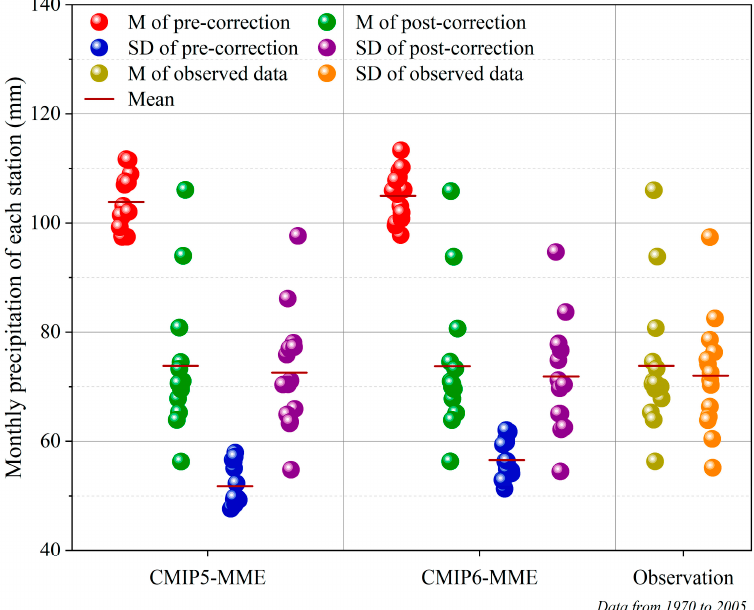
Figure 3. Mean (M) and standard deviation (SD) scatter plots of monthly precipitation before (pre-correction) and after (post-correction) deviation correction of CMIP5-MME, CMIP6-MME, and observed data for each station. After temporal downscaling, the downscaled daily values for 14 stations in the HRB were evaluated. The QQ plots of observation versus GCM daily precipitation data for the CMIP5-MME and CMIP6-MME are shown in Figure 4, where the quantiles varied from 0.5 to 99.9 when the stations were aggregated. The station scatter plot points followed a 1:1 line, indicating that the downscaled daily precipitation of the CMIP5-MME and CMIP6-MME fit the observed data well, and the two distributions were similar. When precipitation was low, the downscaled daily precipitation of the CMIP5-MME and CMIP6-MME correlated well with the observed data. However, as precipitation increased, the scatter plot points gradually began to deviate from the 1:1 line, indicating that the CLIGEN model has a weak ability to simulate extreme precipitation, which is consistent with the findings of Su et al. [12].